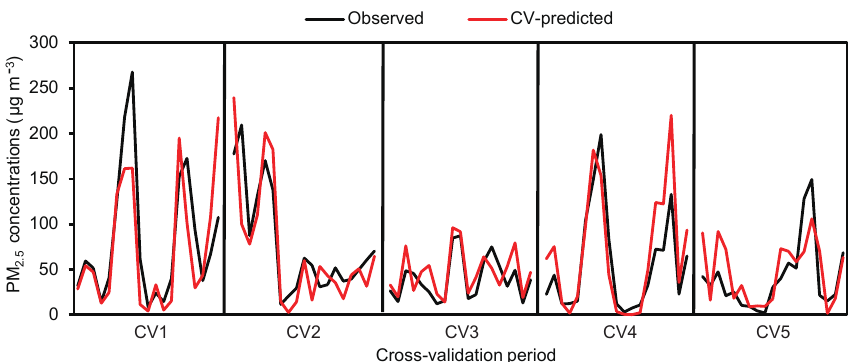
Figure 9. Time series of the observed and cross-validation (CV) predicted PM 2 . 5 concentrations during five CV periods. The black line represents the observed PM 2 . 5 concentration and the red line represents the CV-predicted PM 2 . 5 concentration.